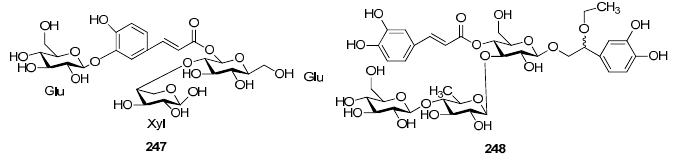
Figure 53 . Structures of compounds 247 – 248 .